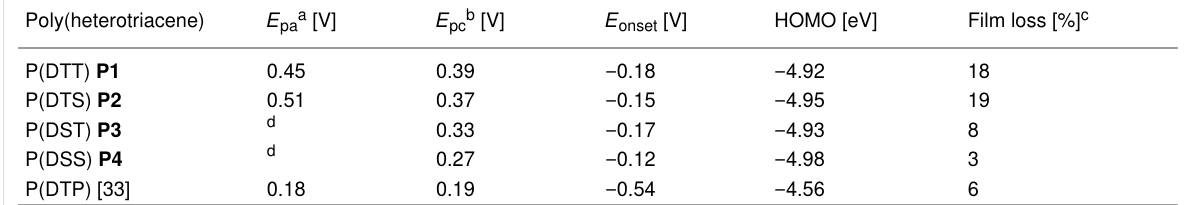
Table 5: Electrochemical properties of poly(heterotriacenes) P1 – P4 and film loss after conducting 30 scans in a monomer-free electrolyte solution.